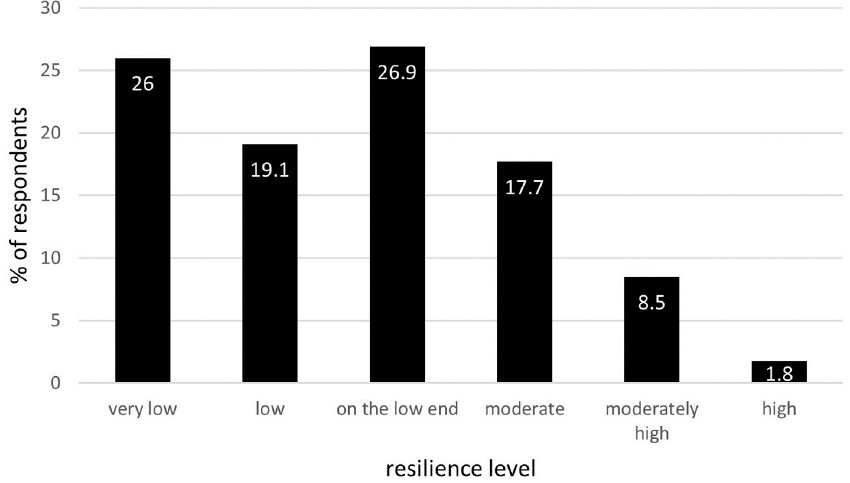
Fig 1. The percentage of respondents presenting particular levels of resilience according to Resilience Scale-14 (N = 1,032). https://doi.org/10.1371/journal.pone.0261652.g001 Burnout A total number of 1311 students answered all MBI-GS(S) questions. Mean scores, which may range from 0 to 6 for each dimension, were 3.9 ± 1.4, 3.5 ± 1.6, and 2.9 ± 1.1 for EE, CY, and AE, respectively. The prevalence of high, moderate, and low levels of burnout in the three Table 3. RS-14 scores depending on medical student characteristics gathered in the self-created survey. RS-14 scores